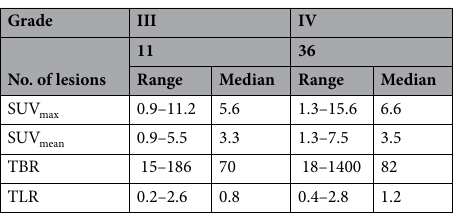
Table 3. Analysed parameters: SUV max , SUV mean , TBR and TLR in the subgroups—per-lesion analysis.